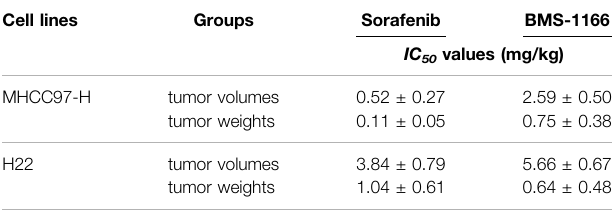
Table notes: H22 cells were still inoculated into BalB/c mice, and after MHCC97-H cells wereinoculatedintoSCIDmice,theSCIDmicewereinfusedwithhealthyhuman-derived peripheralbloodlymphocytes(1×10 7 cellsforeachtimeandperfumedtimetimes).The concentrationsofsorafenib:3,2,1,0.5,0.2,0.1 mg/kginSCIDmiceand10,5,2,1,0.5, 0.2 mg/kg in BalB/c mice; BMS-1166: 10, 5, 2, 1, 0.5, 0.2 mg/kg in SCID mice and 20, 10, 5, 2, 1, 0.5 mg/kg in BalB/c